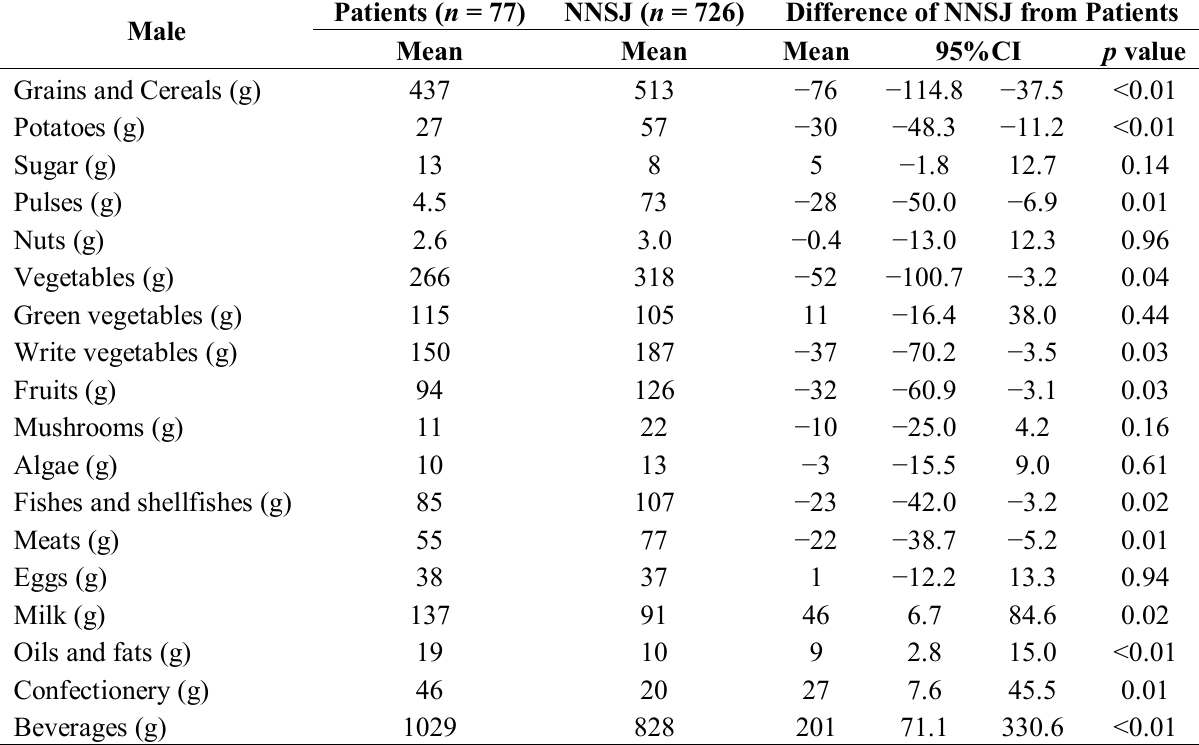
Table 2. The intake of food groups and nutrients in male patients, and comparison with the National Nutrition Survey of Japan (NNSJ) (per